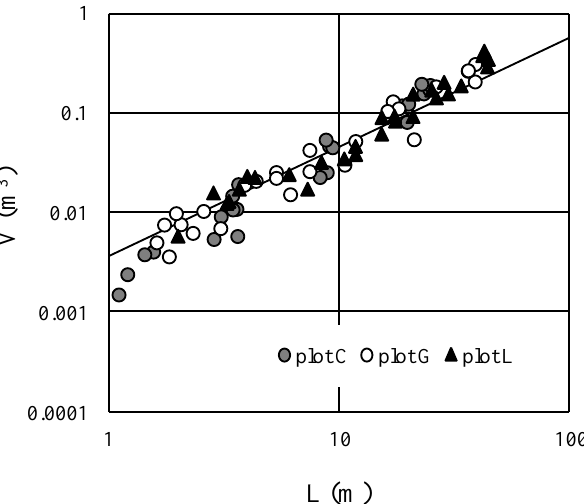
Figure 16. Comparison between the L - V power equation and the L - V pairs detected for the plots L (44 m × 8 m), G (33 m × 8 m), and C (22 m × 8 m) using the automatic extraction of the rills (modified from [62]).